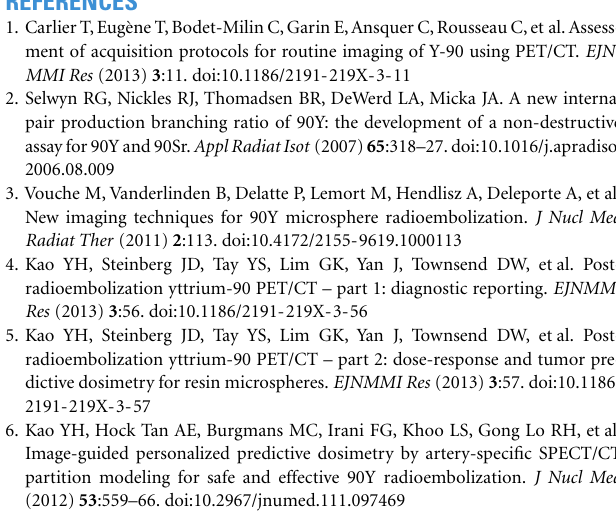
Figure 9 : the importance of deliberately increasing the back- ground noise for non-target activity detection.